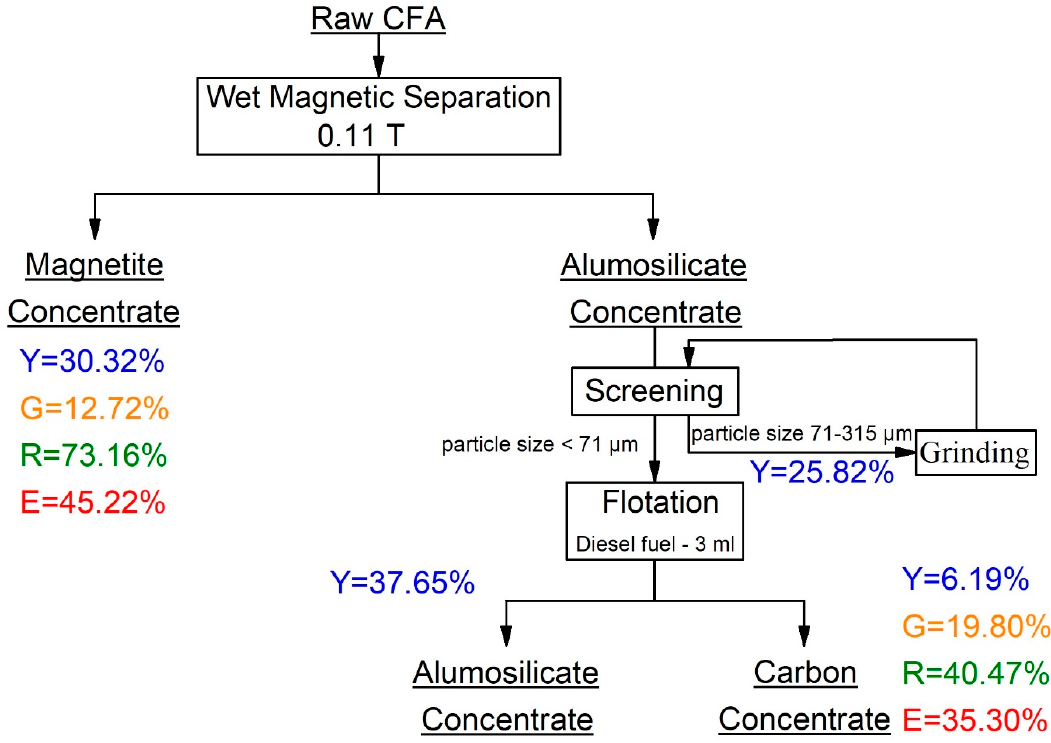
Figure 11. Flowsheet of the CFA enrichment process using wet magnetic separation and flotation (Y—the amount of the magnetite/carbon concentrate relative to the initial mass of the raw CFA, G—grade of magnetite/carbon, R—recovery of magnetite/carbon, E—magnetic separation/flotation efficiency).